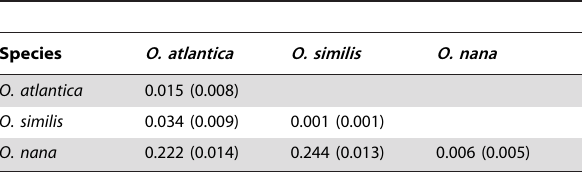
Table 3. Pairwise W ST distances between all O. similis populations with n .